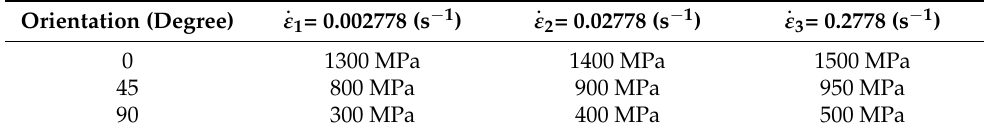
Table 1. Young’s moduli dependent on orientation and engineering strain rate.